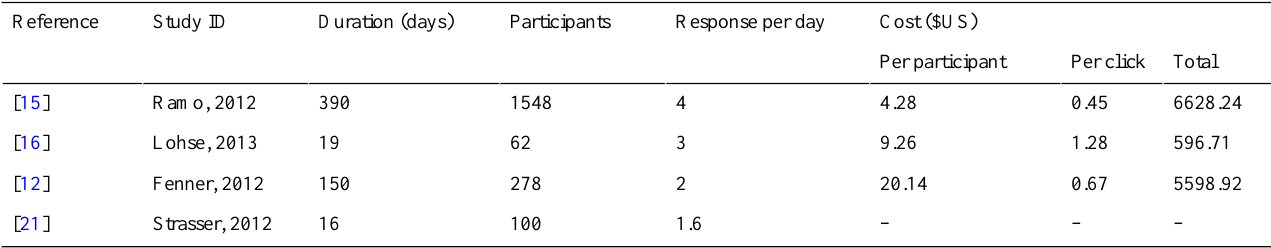
Table 3. Reported cost and timeliness of included